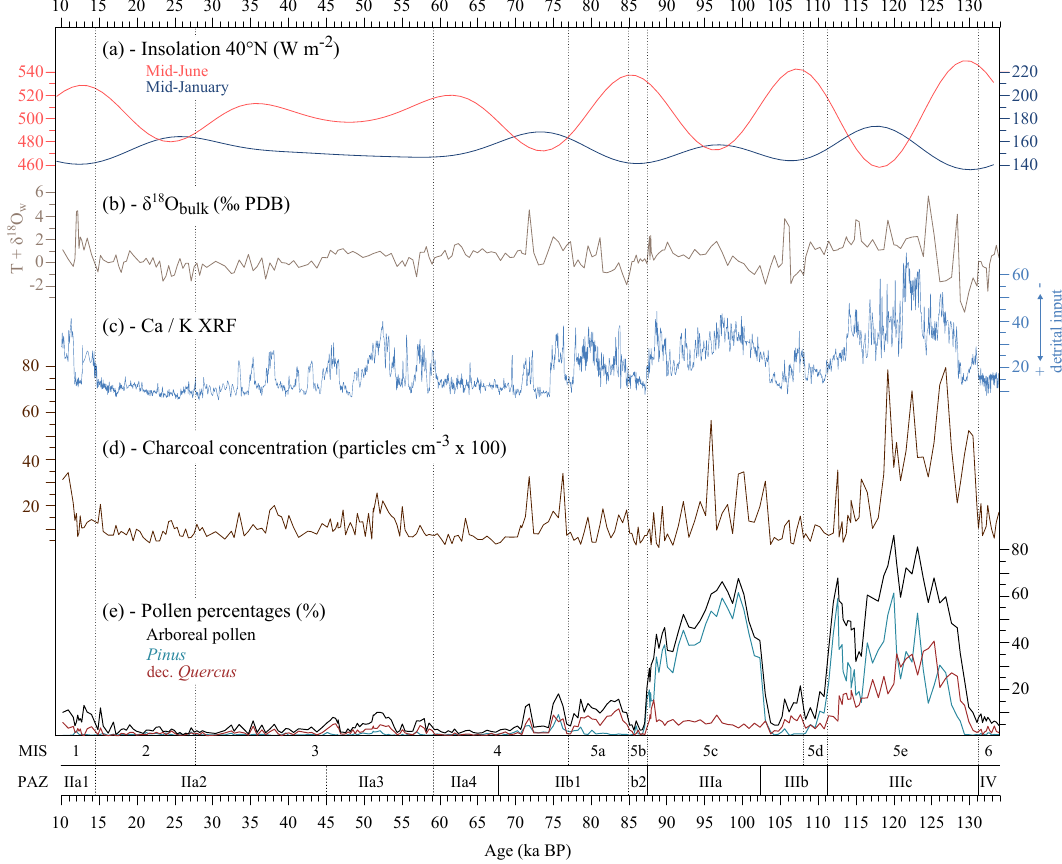
Figure 3. Comparative study of the Lake Van paleoenvironmental sequence encompassing the last glacial–interglacial cycle. (a) Mid- June and Mid-January insolation at 40 ◦ N (Wm − 2 ; Berger, 1978; Berger et al., 2007); (b) Lake Van oxygen isotope record ( δ 18 O bulk in ‰ PDB) of autochthonous precipitated carbonates. Shown is the temperature ( T ) and the isotopic composition ( δ 18 O w ) of the epilimnion; (c) calcium/potassium ratio (Ca / K) after Kwiecien et al. (2014); (d) microscopic charcoal concentration (particles cm − 3 ) from 10–110kaBP (this study) and from 110–135kaBP (MIS 5e; Pickarski et al. 2015); (e) selected Lake Van arboreal pollen percentages (AP, Pinus , deciduous Quercus ) from 10 and 110kaBP (this study) and from 110–135kaBP described in Pickarski et al. (2015). MIS – Marine Isotope Stage; PAZ – Pollen assemblage